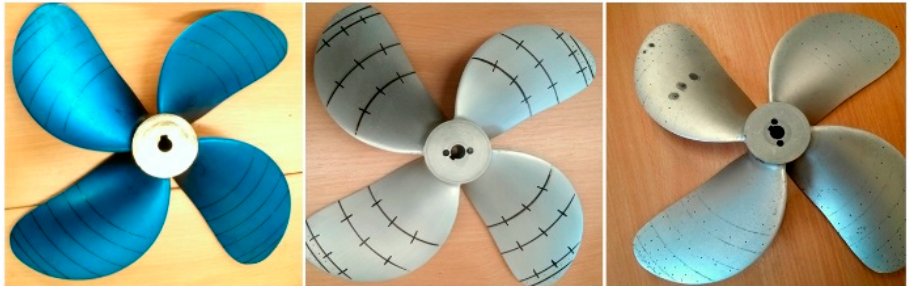
Figure 2. From left to right: “Base” propeller; “Tip” (region) modified propeller; and mid and tip (region) modified, “Sheet” propeller. Reproduced from [13] with permission from Newcastle University.